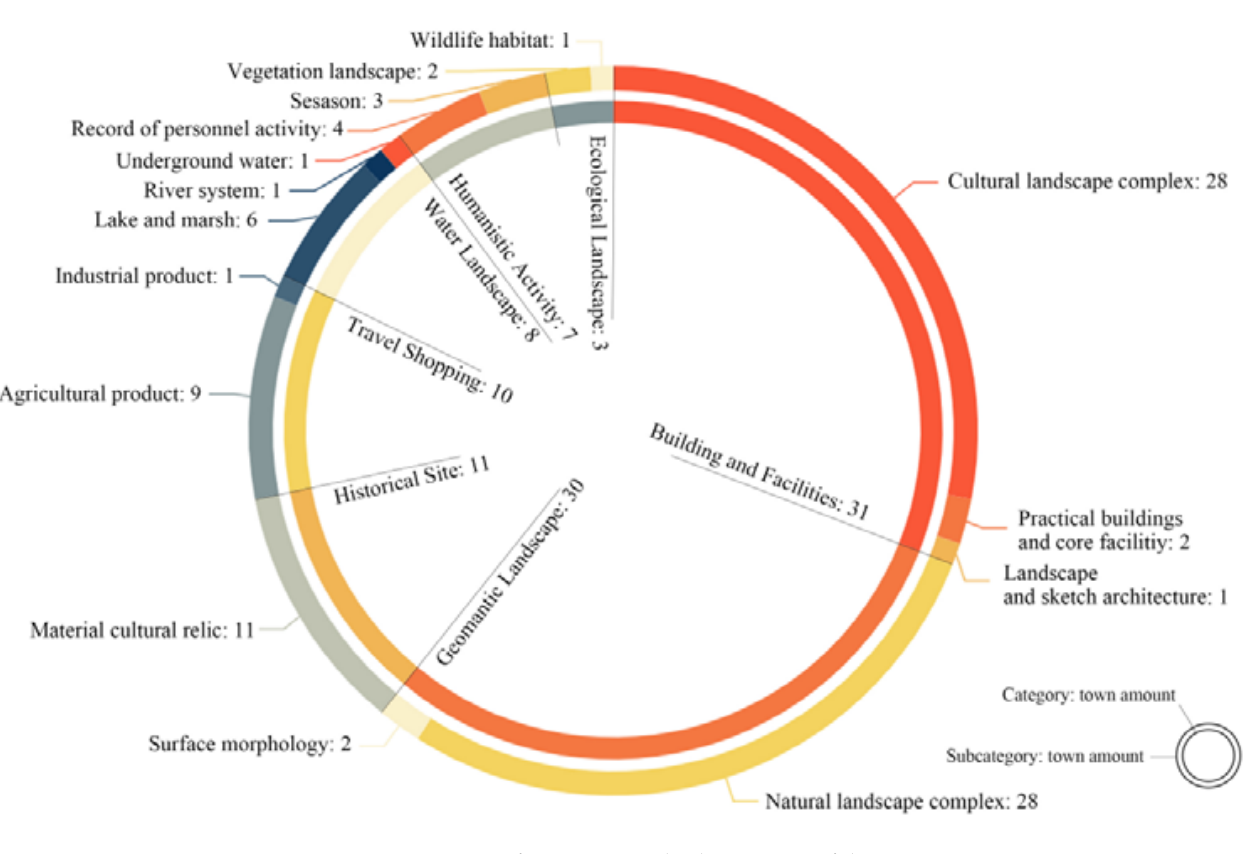
Figure 2. Proportion of categories and subcategories of the NRTTC.